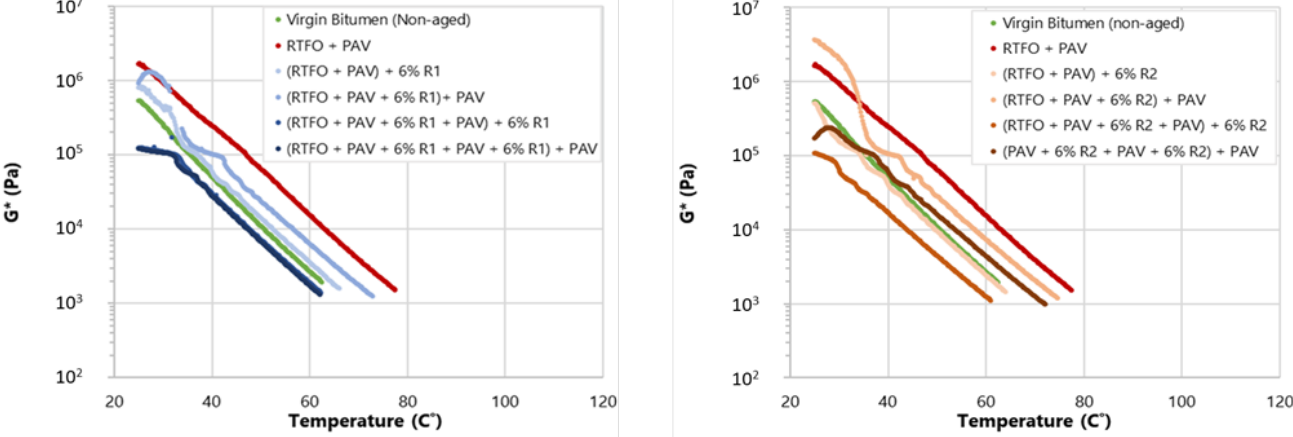
Figure 2. Complex modulus G* vs. temperature of R1- and R2-modified samples.